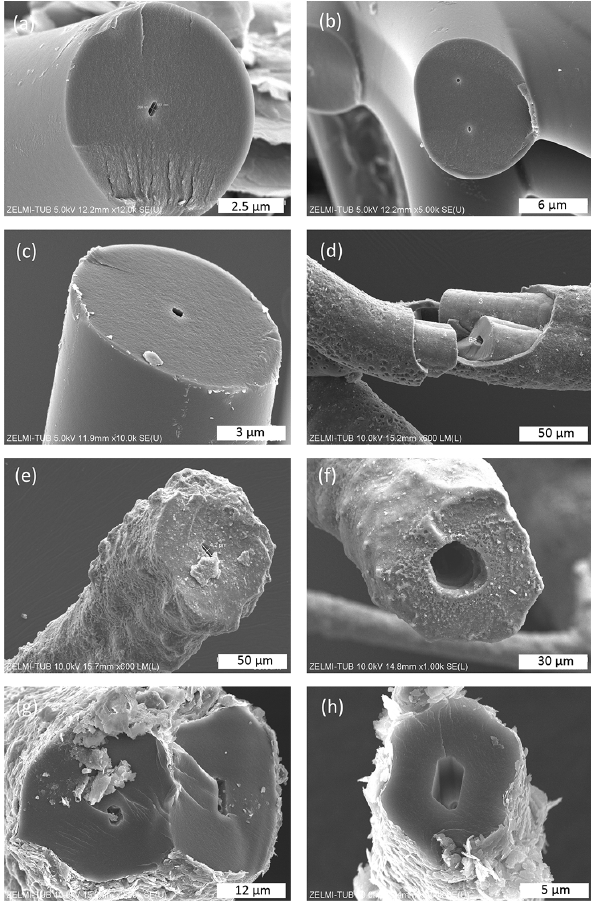
Figure 5. SEM images of surfaces of kerite. (a) Botryoidal sur- face with a shrinking crack; inset shows enlarged part in (b) with a dented surface (sample #5). (c) Ball-shaped end of a filament with (d) dented surface (sample #1). (e) Broken filament (sample #3) showing internal porosity (f, g, h) with irregular outlines a few hun- dreds of nanometers wide. White rectangle in (f) indicates enlarged part shown in (h) .